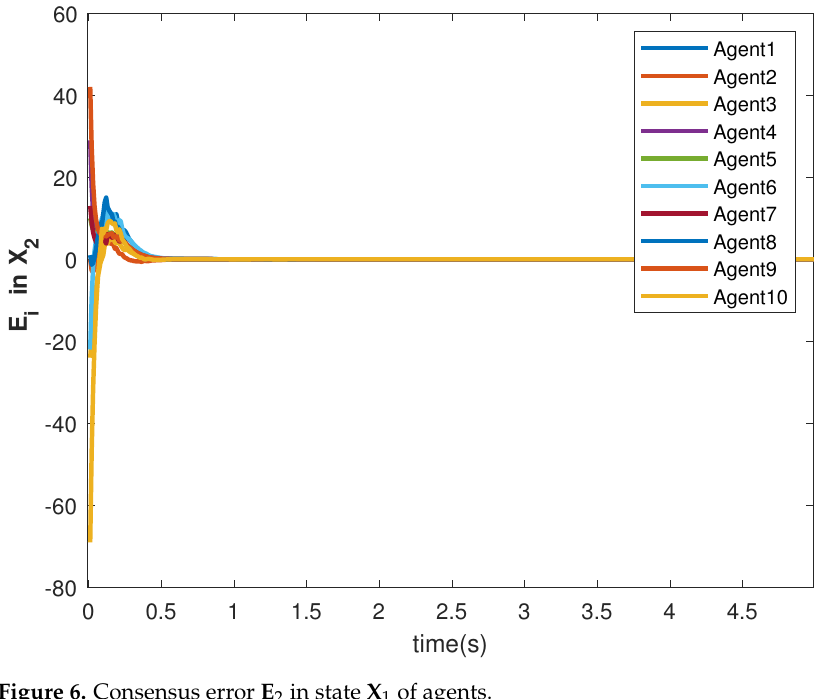
Figure 6. Consensus error E 2 in state X 1 of agents.